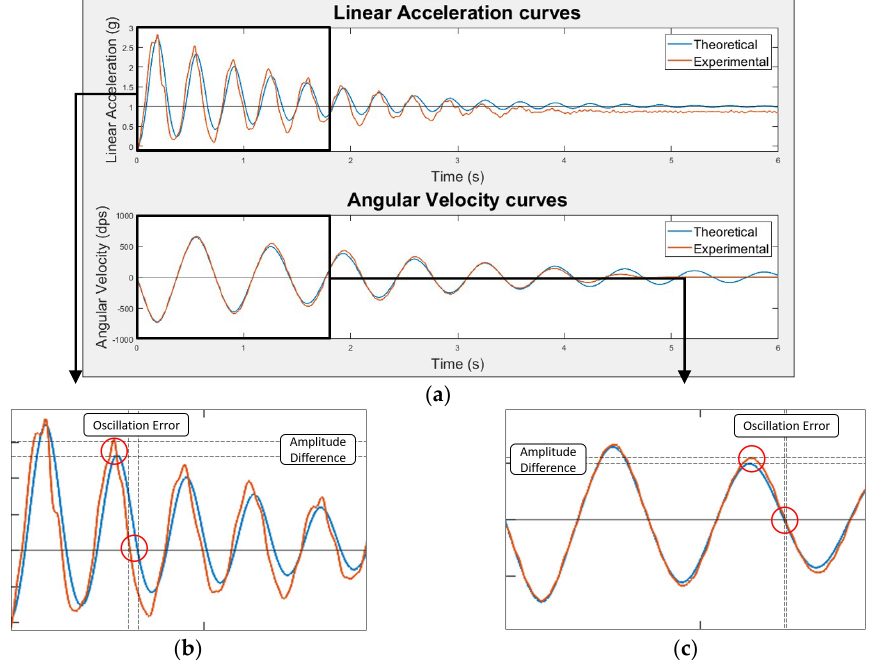
Figure 10. Inertial data validation results: ( a ) Example of a theoretical and experimental angular velocity and linear acceleration signal; ( b ) Linear acceleration curve corresponding to pendulum first 5 oscillations with the comparison results highlighted; ( c ) Angular velocity curve corresponding to pendulum first 5 oscillations with the comparison results highlighted.